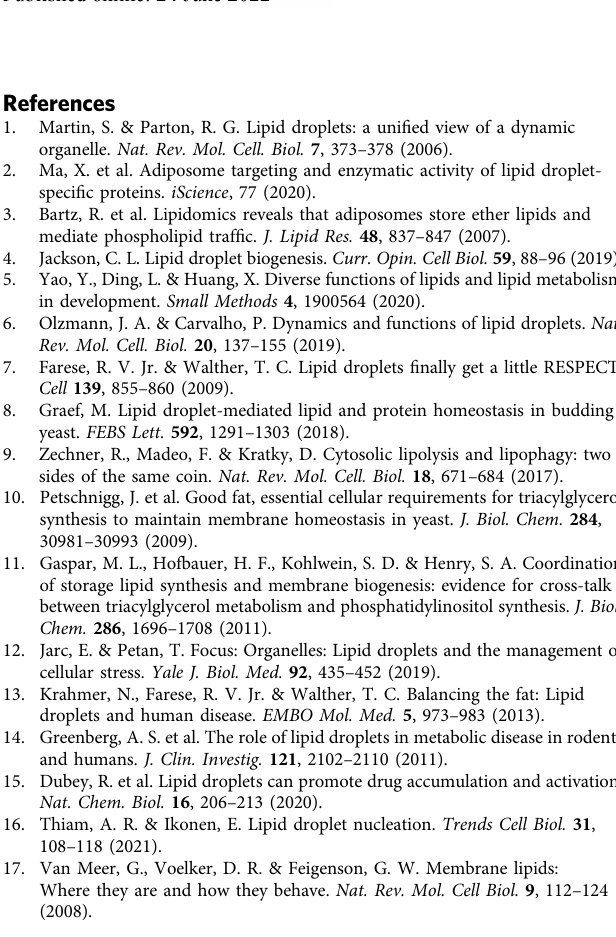
Figure preparation . Figures were prepared using BioRender.Com for scienti fi c illustrations. MD simulation snapshots in Fig. 2 and Supplementary Movie 1 and 2 showing the simulation trajectories were prepared using visual molecular dynamics software version 1.9.4 46 . Statistics and reproducibility . The confocal fl uorescence microscopy experiments in Figs. 3C; 4C and in Supplementary Figs. 3; 4 were performed at least triplicate at two independent